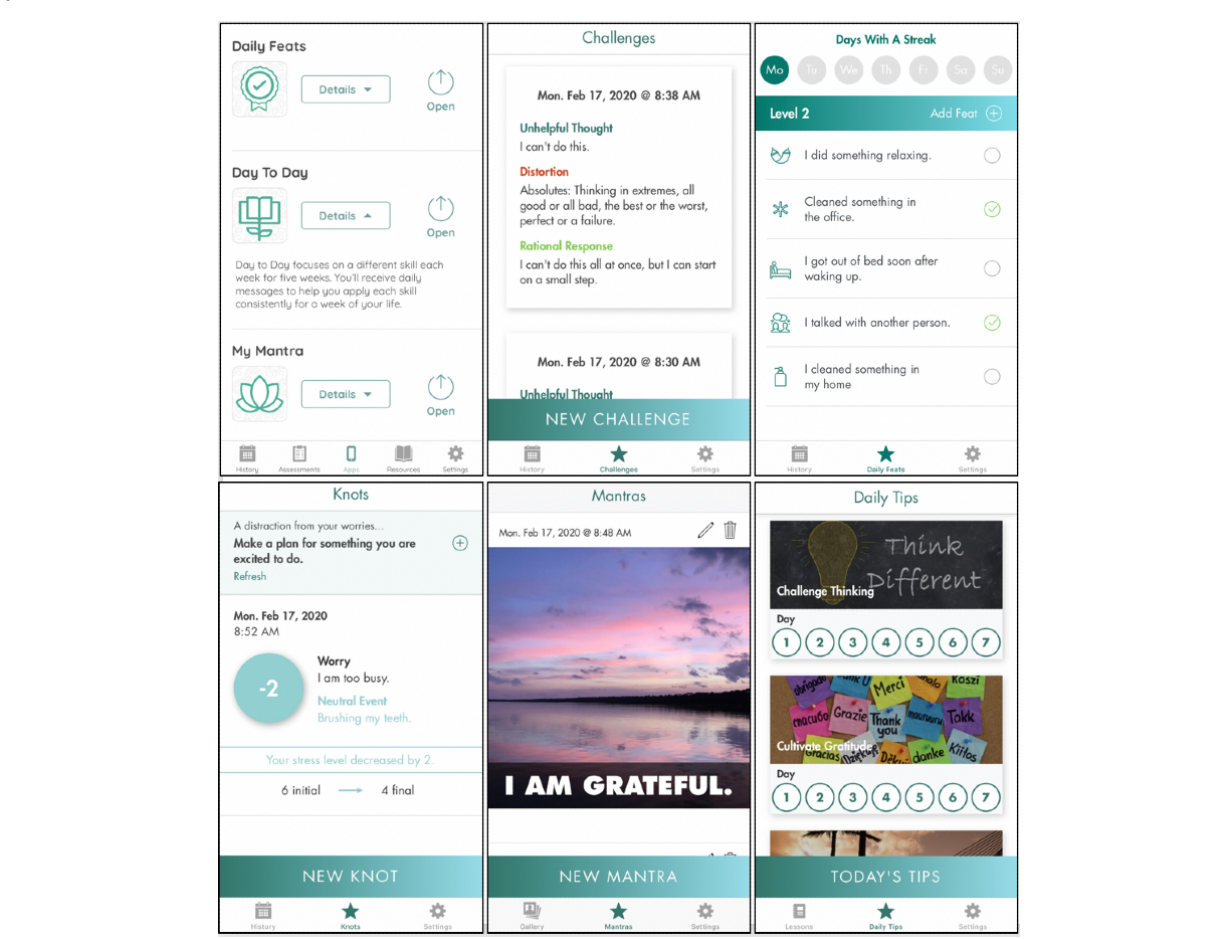
Figure 1. IntelliCare apps. Top row, left to right: Hub , Thought Challenger , Daily Feats . Bottom row, left to right: Worry Knot , My Mantra , Day to Day